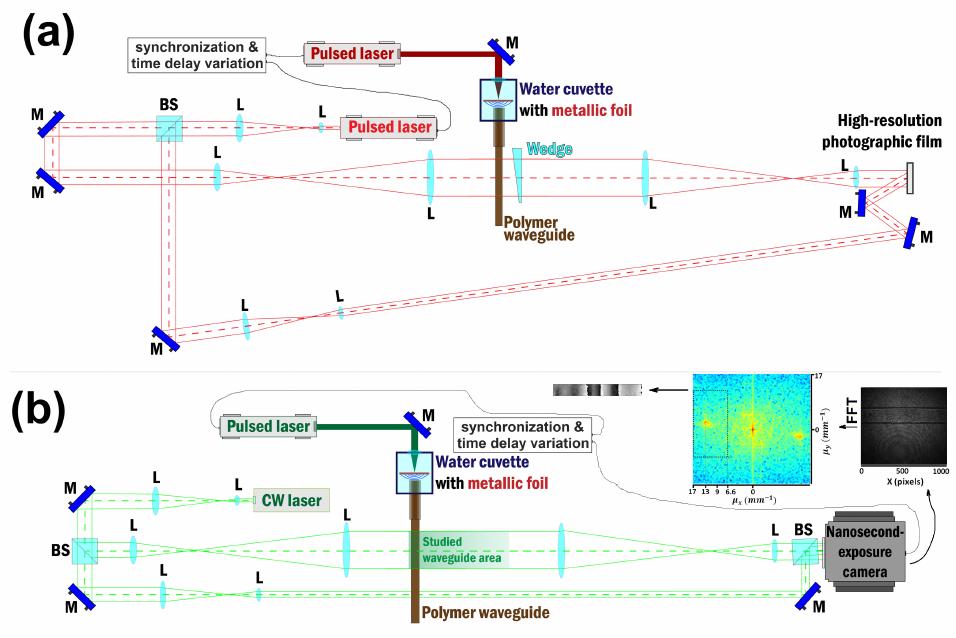
Figure 1. Schematics of experimental setups used for the recording of wave patterns by ( a ) holo- graphic interferometry and ( b ) digital holography. L are lenses, M are mirrors, BS are beamsplitters. A diagram illustrating the digital hologram data processing workflow is shown in the inset in ( b ) (the image in the Fourier domain is shown in the logarithmic